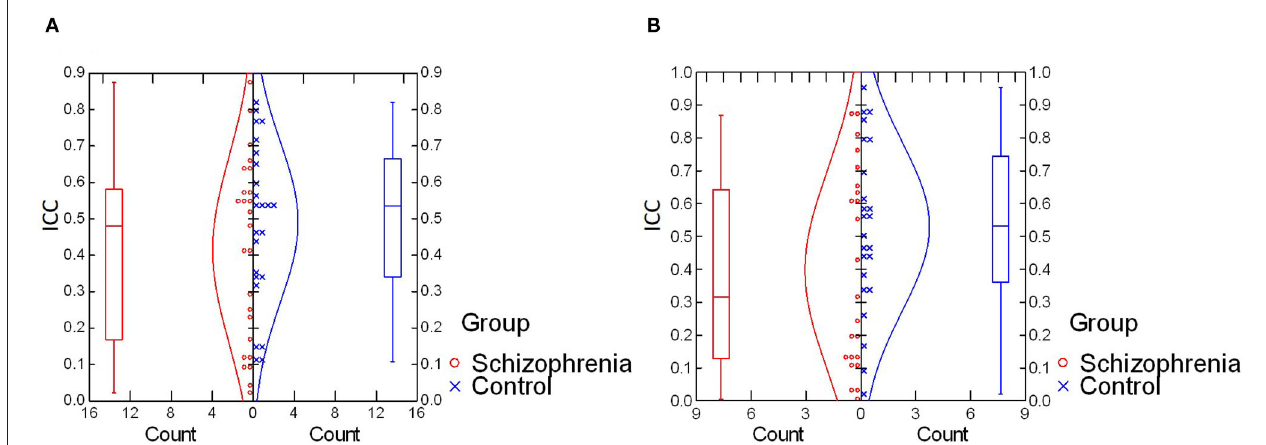
FIGURE 1 | (A) Comparison of intra-individual variability (ICC values) in photopic condition. No significant difference was found for mean ICC values between schizophrenia and control groups [ t (47) = − 1.12, p = 0.27; d = 0.34]. (B) Comparison of intra-individual variability (ICC values) in the scotopic condition. No significant difference was found in median ICC values between schizophrenia and control groups ( U = 208, z = 1.45, p = 0.15; η 2 = 0.03). ICC, intraclass correlation coefficient.